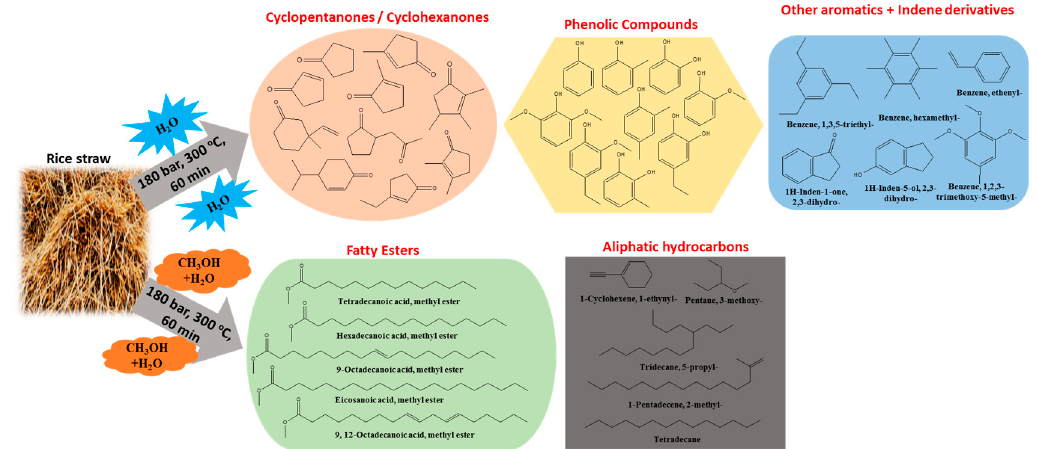
Figure 6. Scheme depicting the typical products produced from HTL of rice straw at different conditions.